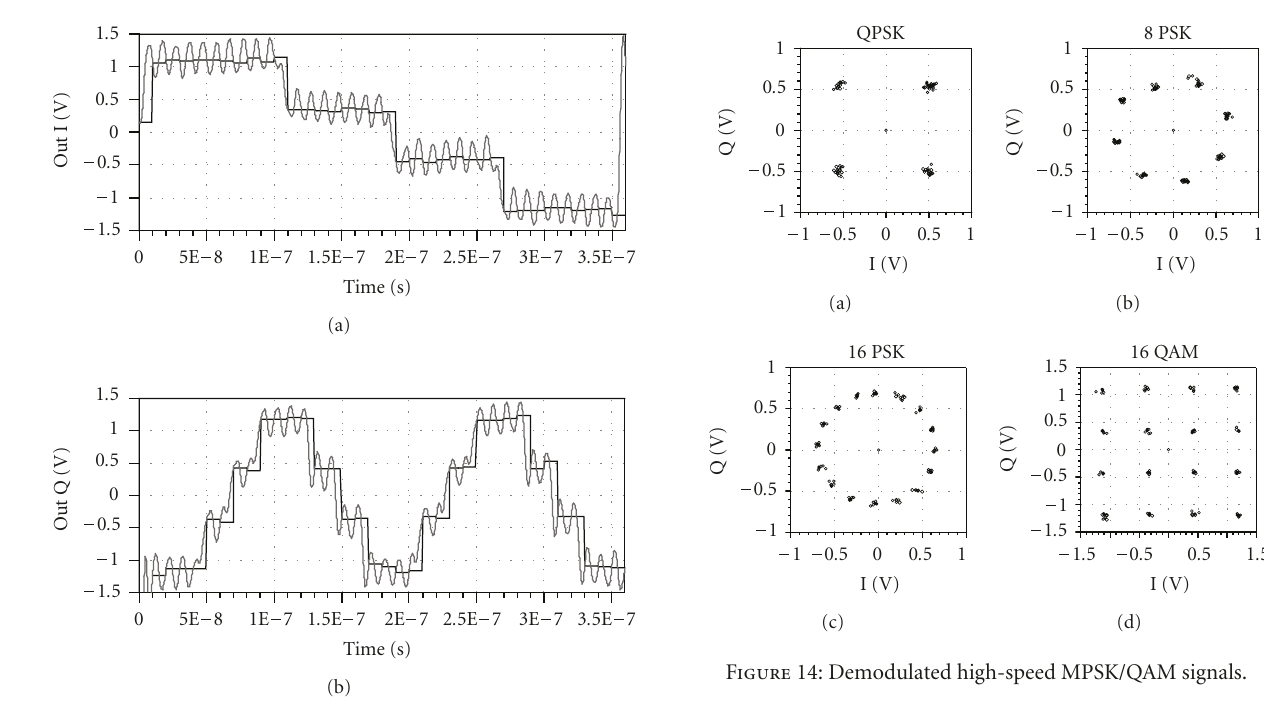
Figure 13: Demodulation results of 16 QAM signal.